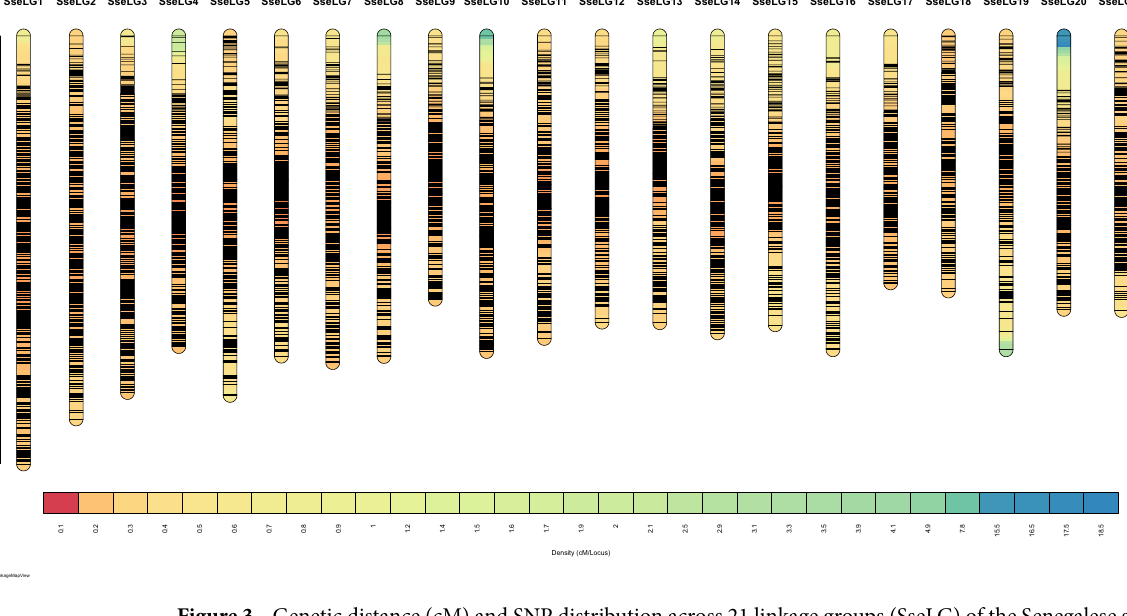
Figure 3. Genetic distance (cM) and SNP distribution across 21 linkage groups (SseLG) of the Senegalese